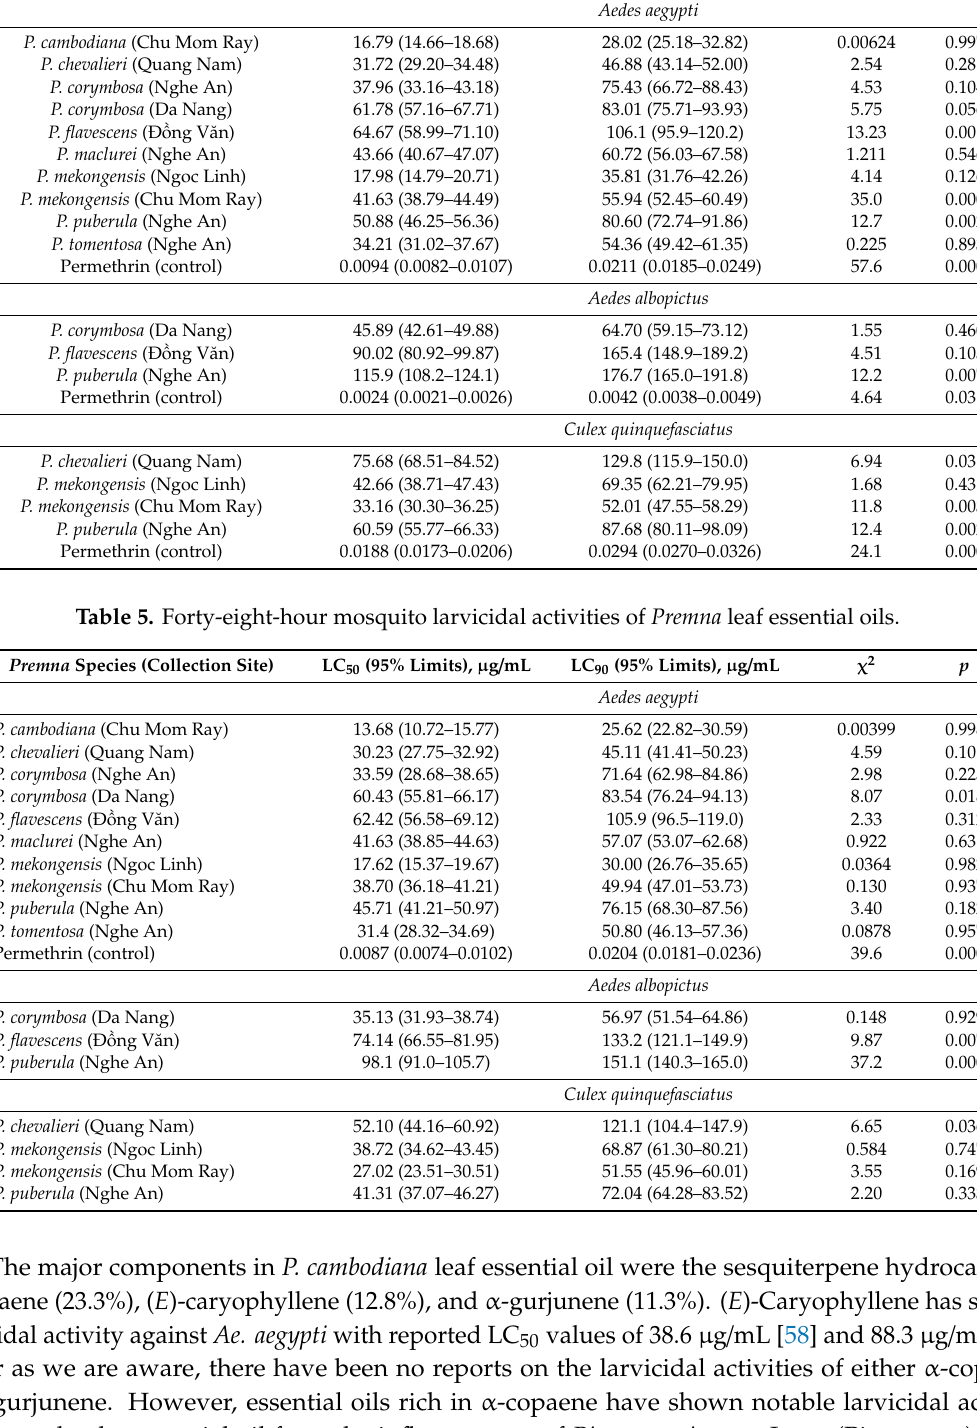
Table 4. Twenty-four-hour mosquito larvicidal activities of Premna leaf essential oils. Premna Species (Collection Site)